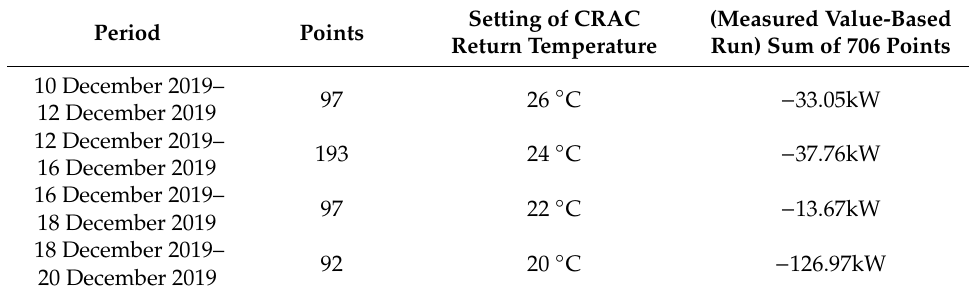
Table 25. When return temperature of the CRAC is set to 20–26 ◦ C (10 December 2019 to 20 December 2019; sample number: 479). Setting of Period Points